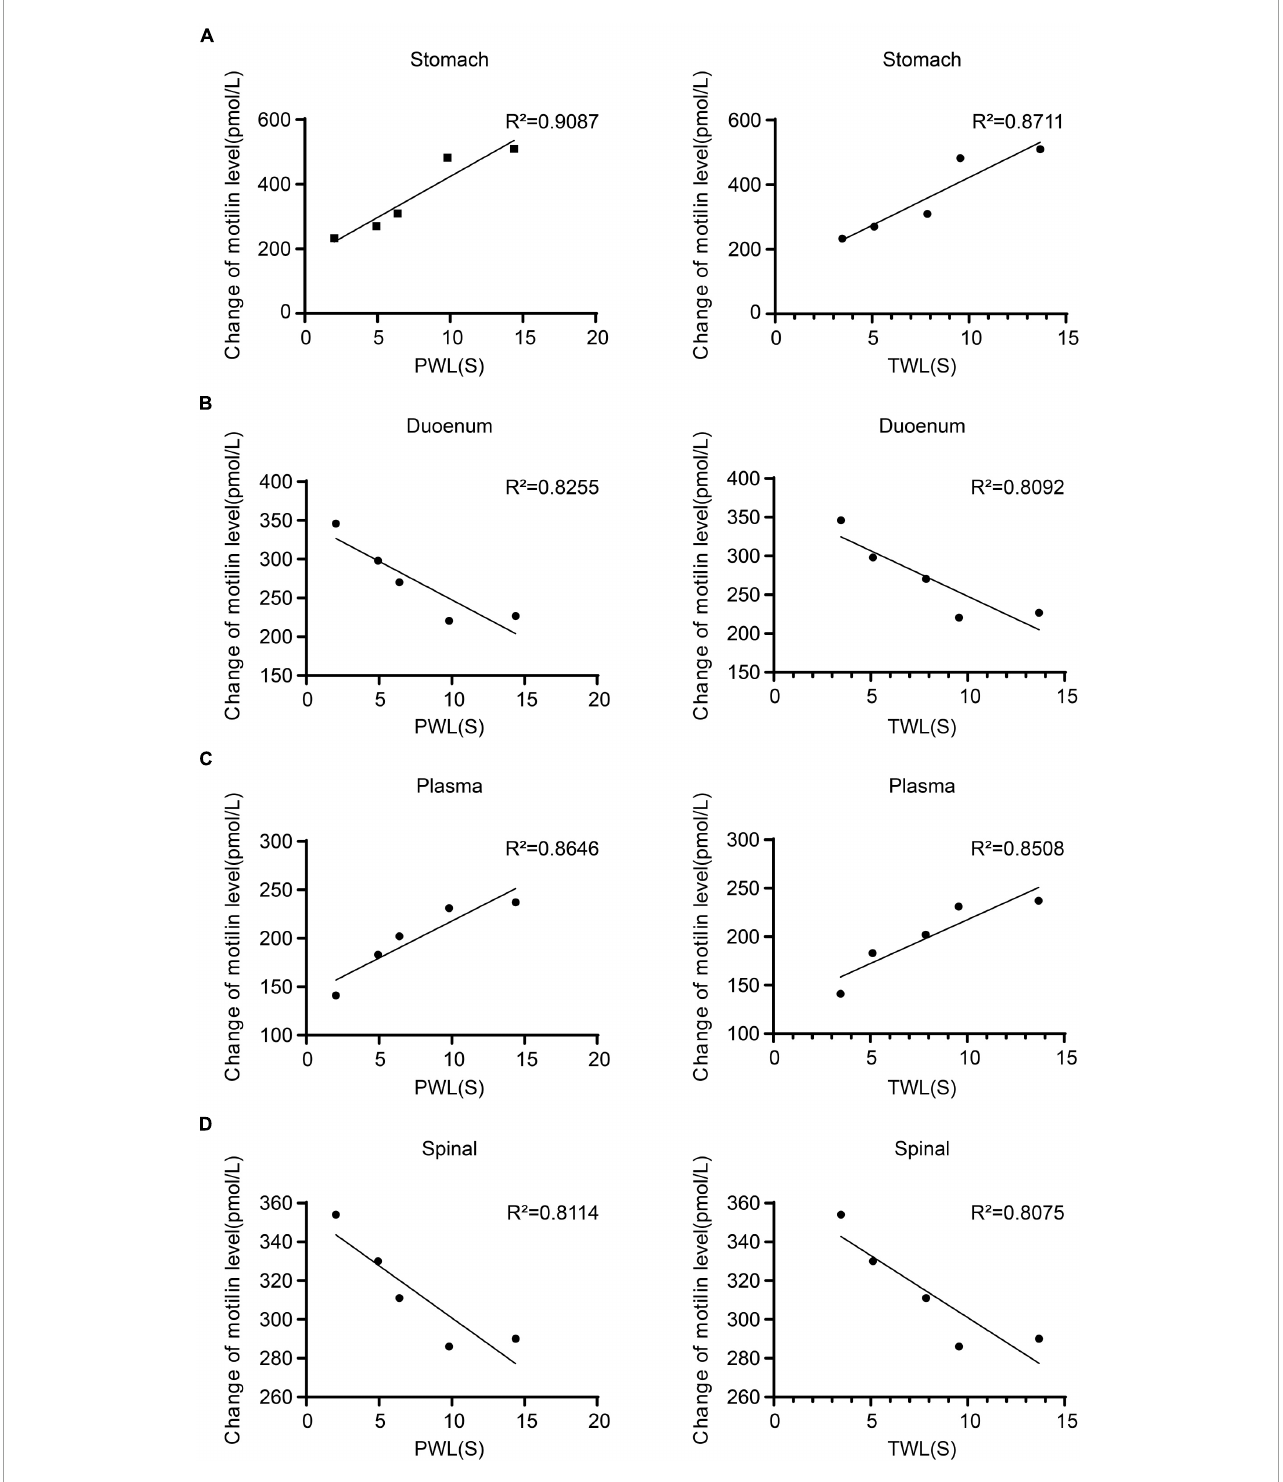
FIGURE5 Regression curves of the correlation between mechanical withdrawal threshold (MWT) measured as paw withdrawal latency (PWL) and thermal withdrawal latency (TWL) and motilin (MTL) expression in (A) gastric body, (B) duodenum, (C) plasma, and (D) spinal cord in rats with incisional pain.